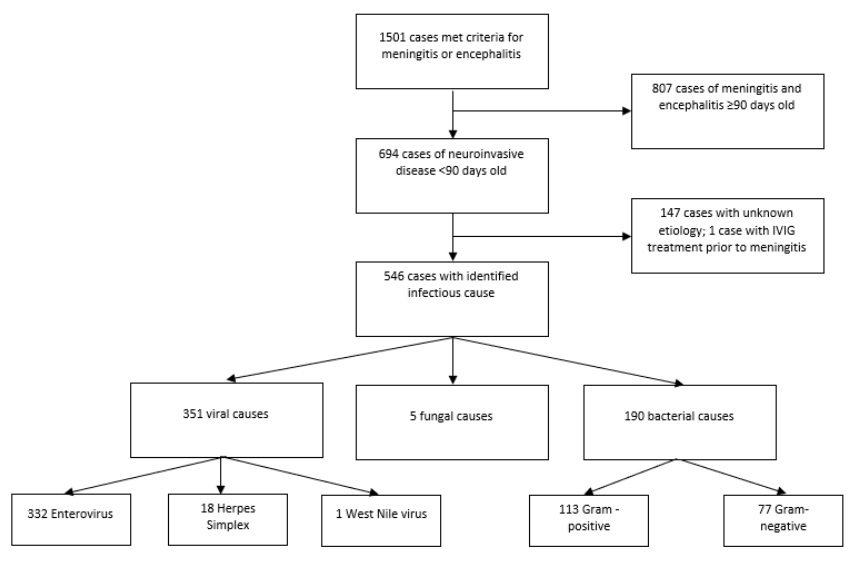
Figure 1. Selection flowchart. Table 1. Demographic and clinical characteristics of meningitis by etiology in infants under 90 days of age, Houston, TX 2010–2017